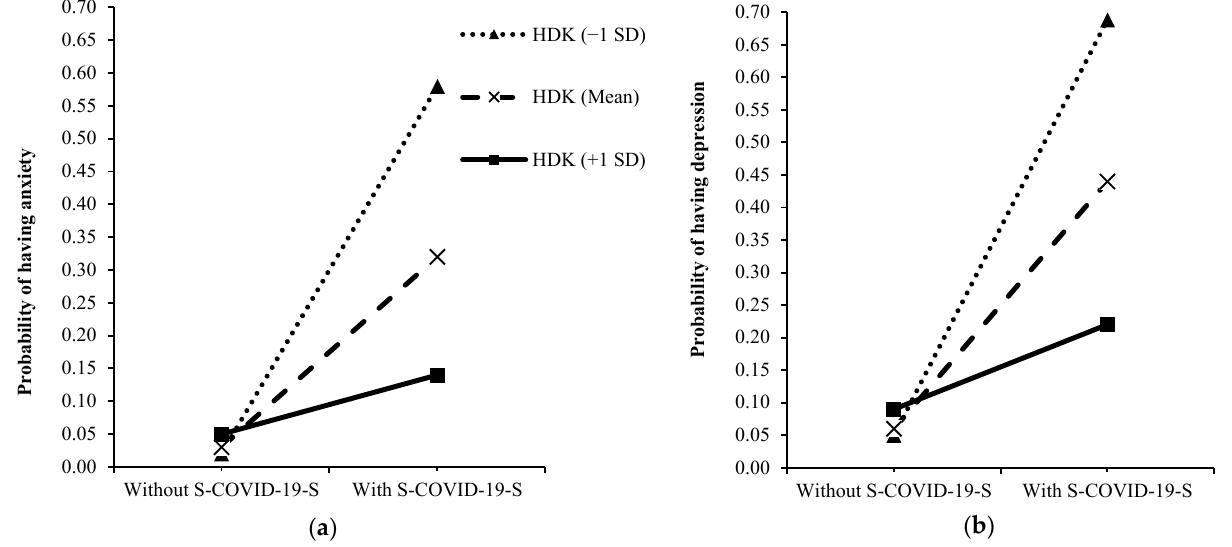
Figure 2. Simple slopes for the interactions between S-COVID-19-S with hemodialysis diet knowledge on anxiety ( a ) and depression ( b ) ( n = 875). Note: HDK, hemodialysis dietary knowledge; S-COVID-19-S, suspected COVID 19 symptoms; +1 SD, one standard deviation above the mean; − 1 SD, one standard deviation below the mean.